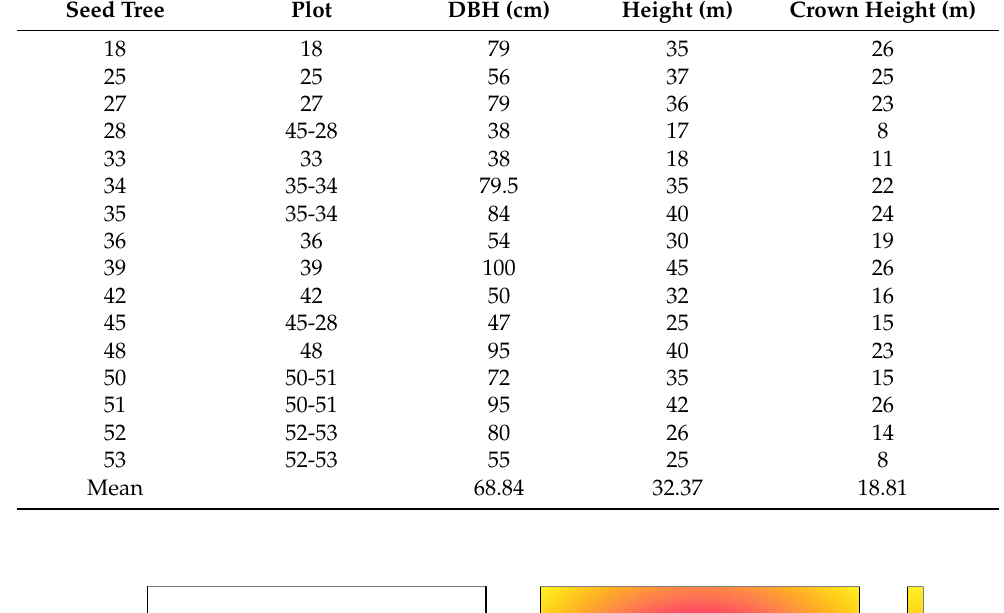
Table 1. Characteristics of the seed trees; ‘crown height’ indicates the lowest point of the living crown. Seed Tree